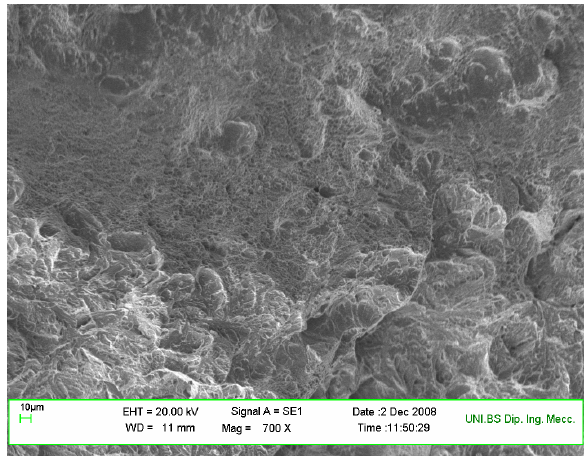
Figure 5. Fracture surface of the sample aged at 524 ◦ C for 120 h and tested at − 80 ◦